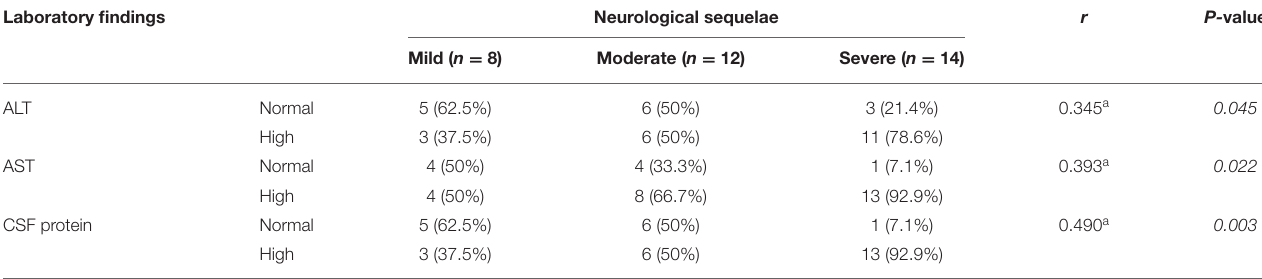
TABLE 3 | The association between laboratory findings and neurological sequelae of ANE. Laboratory